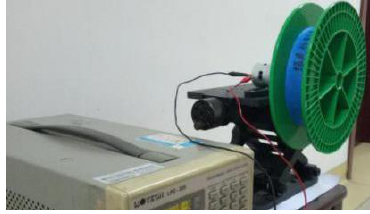
Figure 3 . Spinning disc target.